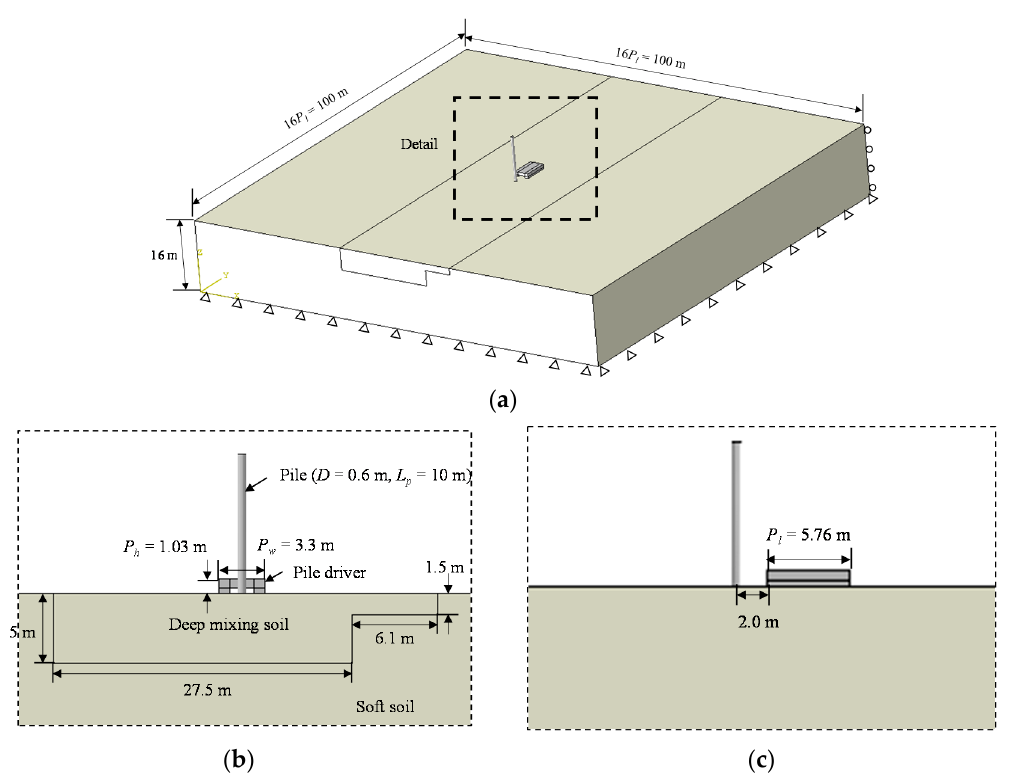
Figure 12. CEL model and boundary conditions for the simulation of pile installation on deep mixing soil: ( a ) 3D view; ( b ) front view; and, ( c ) side view.